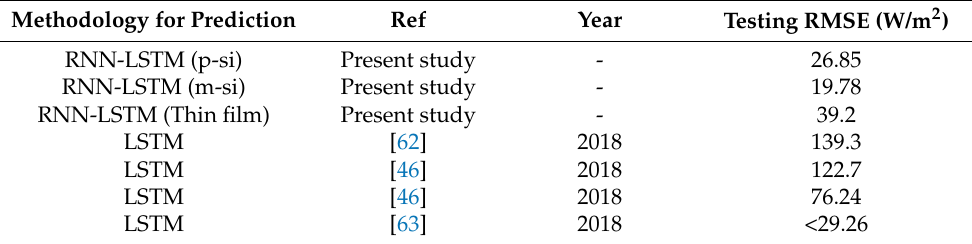
Table 4. Comparison of the suggested method’s forecasting accuracy to the literature. Methodology for